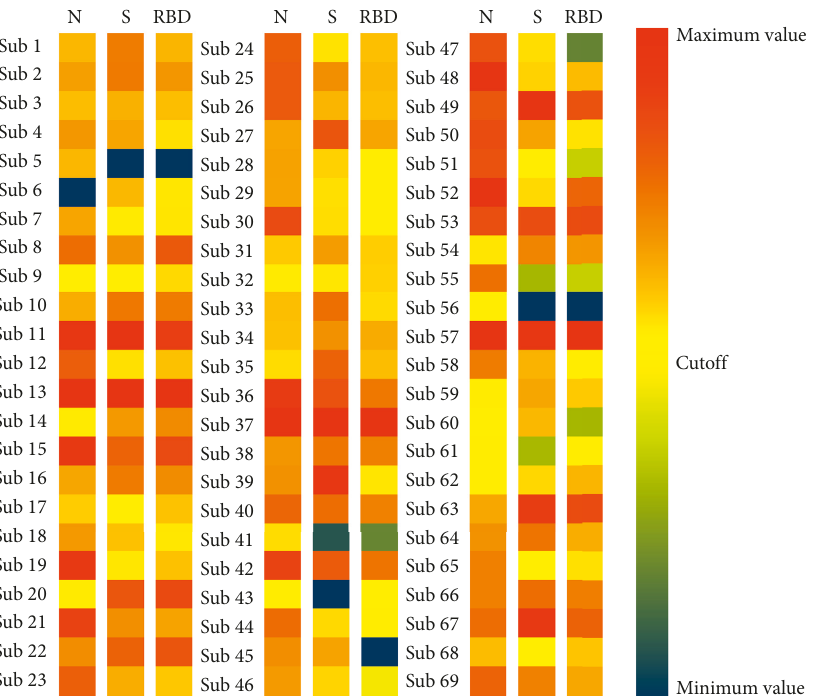
Figure 3: Heatmap showing the average reactivities to the three antigens in individual patients. The heatmap was constructed using only the 69 patients with a positive diagnosis for COVID-19 by RT-qPCR, and the samples were collected between 15 to 30 days after a positive molecular diagnosis. The absorbance values found for each protein were normalized based on the cutoff point found for each protein (N, S, and RBD fraction). The color gradient bar represents lower reactivity against antigens in dark blue and higher reactivity against antigens in dark